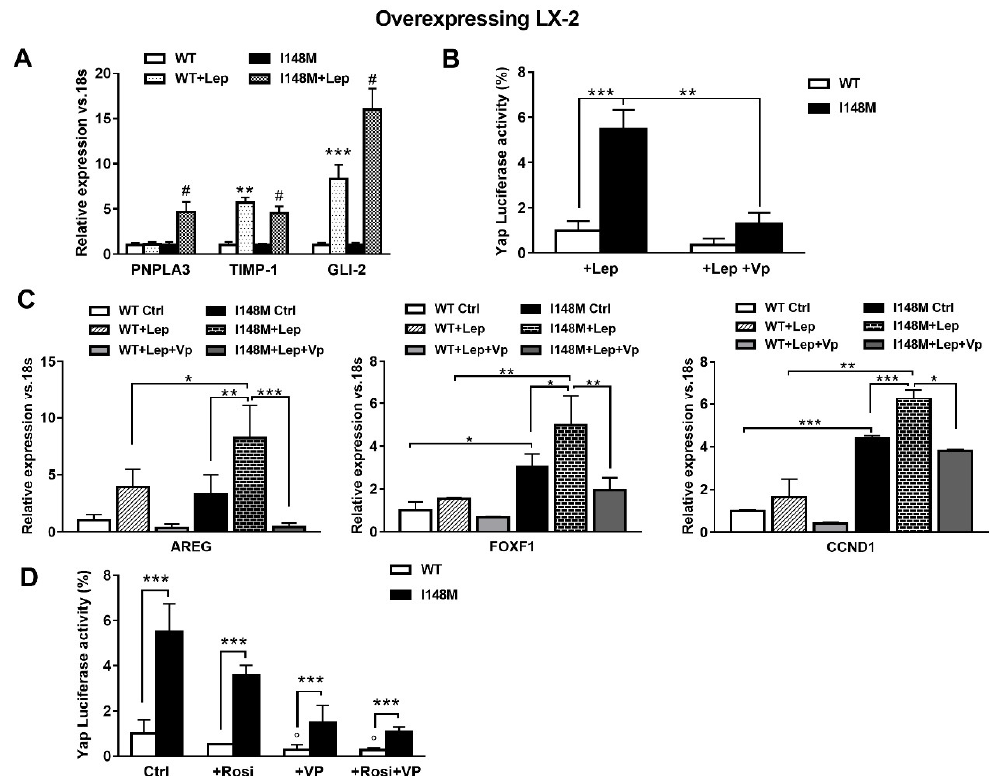
Figure 5. Verteporfin down-regulates leptin-mediated Hedgehog / Yap target gene expression. LX-2 stably overexpressing cells ( n = 3 each PNPLA3 genotype) was obtained and cultivated in vitro, as described in Materials and Methods. Where indicated, cells were stimulated with Vp and Lep, respectively, for 24 and 1 h prior to the analysis. ( A ) Expression of PNPLA3, TIMP-1 and GLI-2 was analyzed by real-time PCR and normalized to 18s. ** = p < 0.01, *** = p < 0.001 vs. WT; # = p < 0.001 vs. I148M. ( B ) Luciferase activity (%) in HSCs transiently transfected with Yap promoter luciferase construct and treated with Lep alone or combination of Lep + Vp. ** = p < 0.01, *** = p < 0.001 as indicated in the graph. ( C ) Expression of AREG, FOXF1 and CCND1 was analyzed by real-time PCR and normalized to 18s. * = p < 0.05, ** = p < 0.01, *** = p < 0.001 between groups as indicated in the graph. ( D ) Luciferase activity in HSCs transiently transfected with Yap promoter luciferase construct and treated with Vp alone, Rosiglitazone (Rosi) alone or the combination of both. *** = p < 0.001 vs. relative WT bar; ◦ = p < 0.01 vs. relative WT